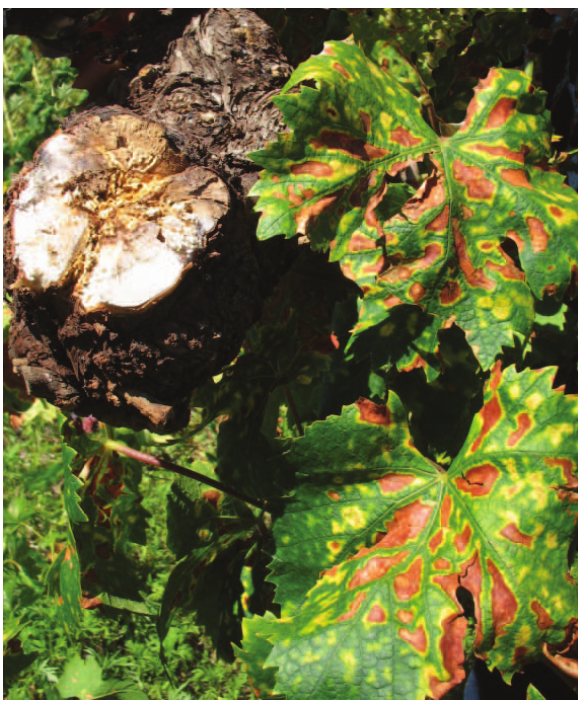
Fig. 4. Typical symptoms of esca in the leaves and the wood of an old grapevine. The leaves show the typical tiger-like necrosis and chlorosis, and the trunk shows white rot. Photo Laura Mugnai, Firenze, Italy.